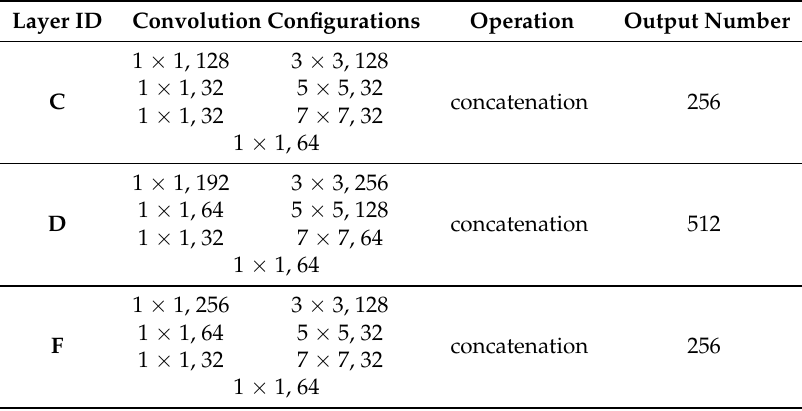
Figure 5. Structure of the inception block and the residual block. Table 2. Configurations of the inception blocks.